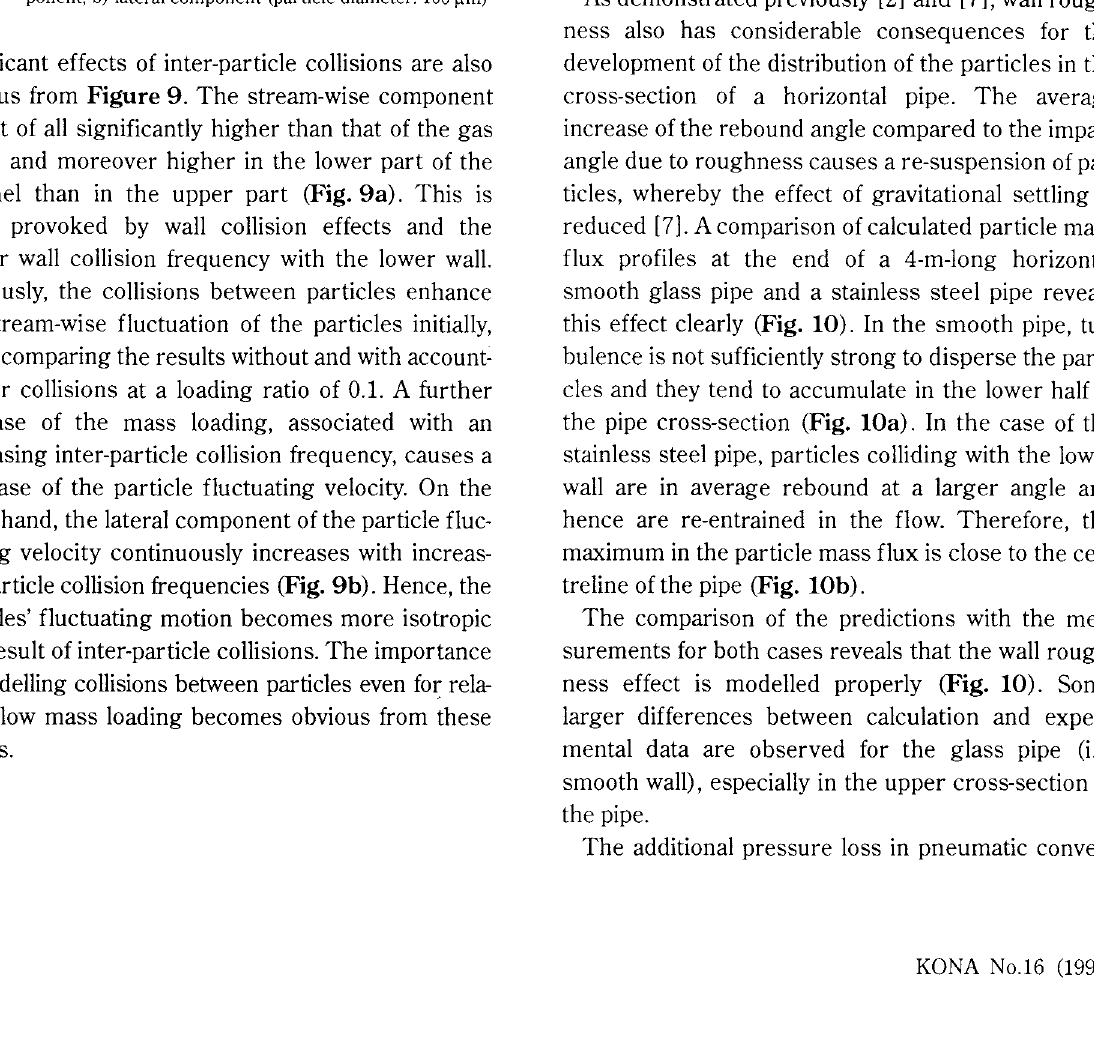
Fig. 9 Influence of inter-particle collisions on the profiles of the fluctuating velocities of the particles, a) stream-wise com ponent, b) lateral component (particle diameter: 100